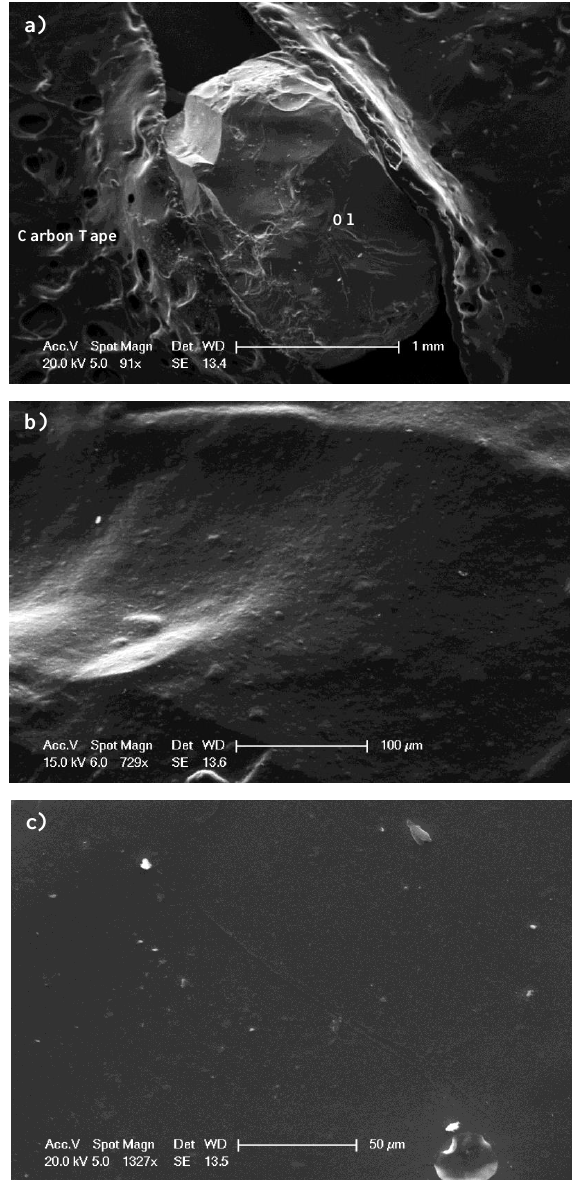
Figure 5. SEM imagery for an olivine phenocryst from an Icelandic picritic basalt lava. (a) Olivine grain bounded by mounting tape showing overall morphology of crystal grown from melt. (b + c) Detailed images of primary surfaces (unfractured) typical of phe- nocrystic olivine which shows minimal